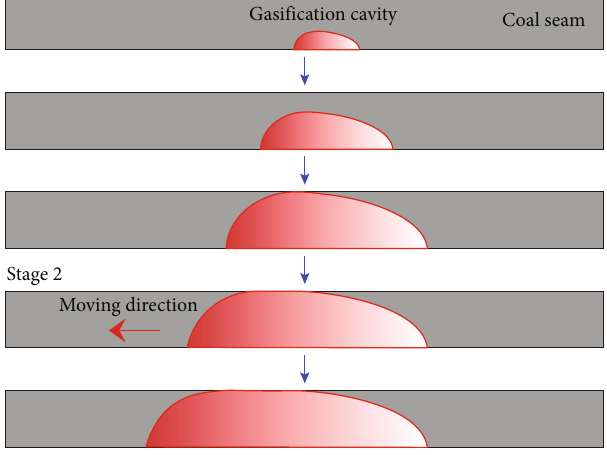
Figure 8: Two-stage development process of combustion